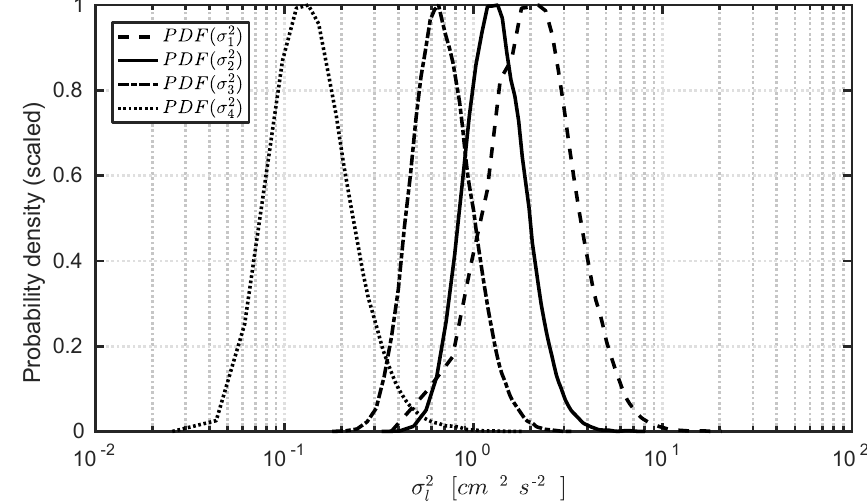
Figure 9. Posterior probability distributions of prediction uncertainty parameters (each PDF curve is scaled to have unit peak height for better